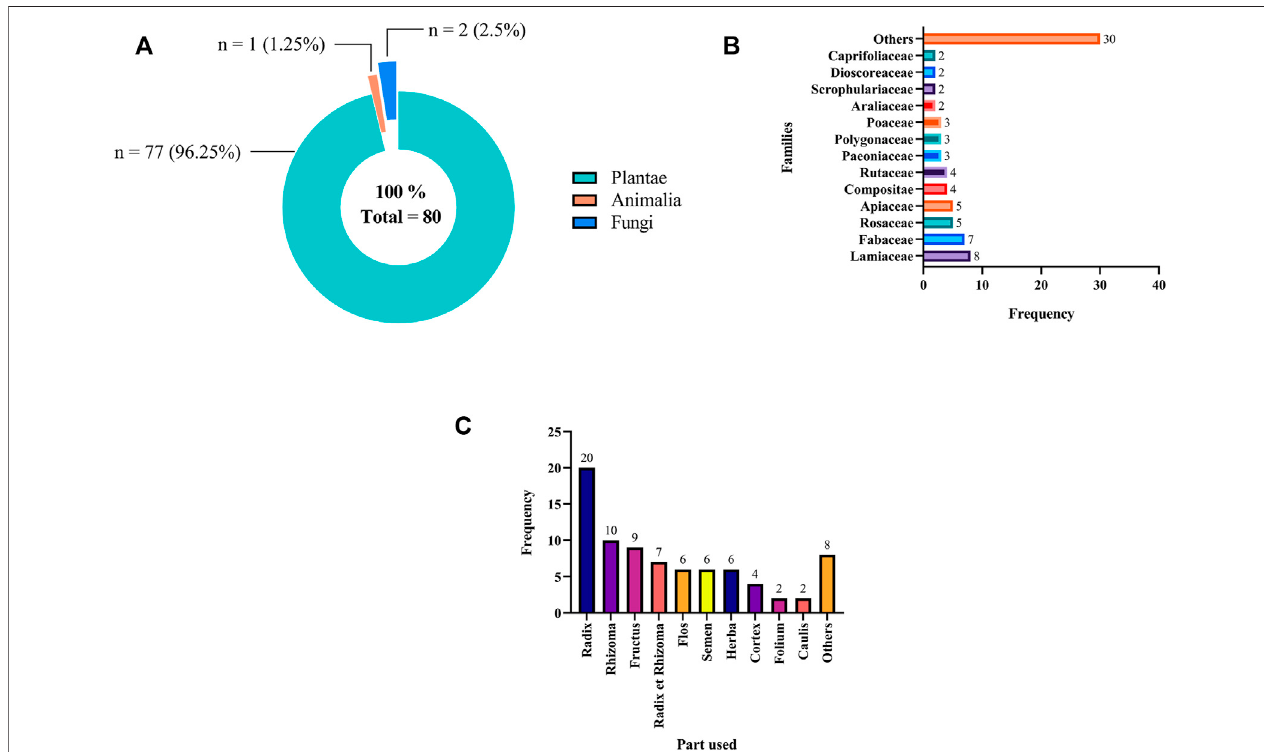
FIGURE2| Classi fi cationof80TCMmaterialsfrom91hypolipidemicformulae (A) kingdom (B) family (C) partused.Note:Partswithafrequency=1inthebarchart were combined in Others.